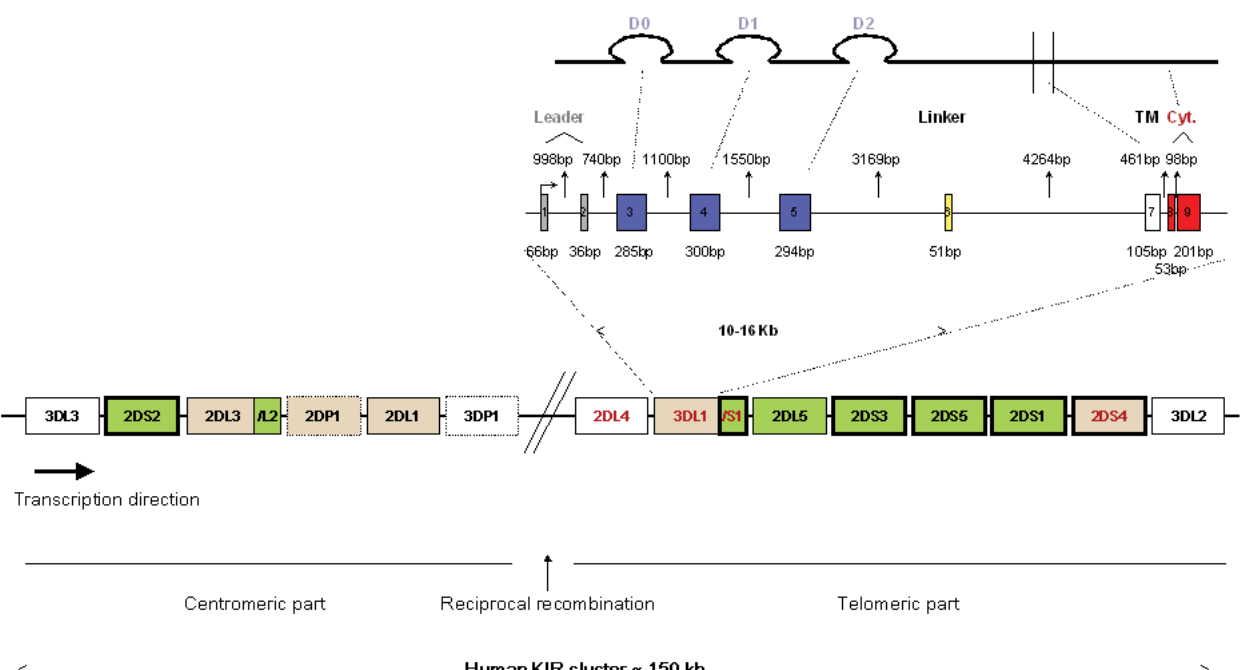
Figure 1. Organisation of the human KIR cluster. The Killer-cell Immunoglobulin-like receptor (KIR) genes are organised in a head-to-tail fashion on human chromosome region 19q13.4. Each gene has nine exons (illustrated for KIR3DL1 ) and is roughly 10–16 kb in length, with short and equally homologous intergenic sequences of about 2 kb separating each pair of genes. The organisation of the exon-intron structure of the different KIR genes is fairly consistent with the following basic arrangement: the signal sequence is encoded by the first two exons (in grey), each Ig domain (D0, D1, D2) corresponds to a single exon (exons 3–5, respectively, in blue), the linker (in yellow) and transmembrane (in white) regions are each encoded by a single exon (exons 6 and 7, respectively), and the cytoplasmic domain is encoded by two final exons (8 and 9, in red). Two systems have been generated for naming KIR genes. The first follows the CD nomenclature system as CD158a, CD158b, etc., based on an approximate centromerictelomeric order of the genes on chromosome 19 [58]. As the CD nomenclature is not used routinely since it does not reflect structure, function, expression or localization, the Human Genome Organization (HUGO) nomenclature will be used throughout this report (www.gene.ucl.ac.uk/nomenclature/genefamily/kir.html). The HUGO nomenclature system, accounts for KIR protein structure and consists of four major subdivisions based on two features: the number of extracellular Ig domains (2D or 3D) and the length of the cytoplasmic tail (L: long or S: short). This latter information determines their functions: inhibitory (L) or activating (S). The boxes in bold indicate the activating KIR genes, and the dotted boxes correspond to the pseudogenes. The two boundary genes of the KIR cluster, KIR3DL3 and KIR3DL2, and the centrally situated KIR3DP1 pseudogene and KIR2DL4 are present in almost all individuals and are therefore considered to be framework (or anchor) genes (shown in white) [59]. KIR3DL3 and KIR3DP1 delimit the centromeric part of the KIR locus, whereas KIR2DL4 and KIR3DL2 delimit the telomeric part. A 14 kb stretch of unique sequence separating KIR3DP1 from KIR2DL4 is the preferred site for reciprocal recombination, a mechanism resulting in the formation of new haplotypes by the reassortment of centromeric and telomeric genes. Apart from these framework genes, KIR gene content is highly variable in terms of both the number and type of genes present. Although initially considered to be separate genes, KIR2DL2 and KIR2DL3 segregate as alleles of the same locus. Similarly, KIR3DS1 segregates as an allele of the inhibitory KIR3DL1 . Overall, there are nine variable genes— KIR2DS2, KIR2DL2/2DL3, KIR2DL1, KIR3DS1/3DL1, KIR2DL5, KIR2DS3, KIR2DS5, KIR2DS1, KIR2DS4 —and one variable pseudogene ( KIR2DP1 ). KIR2DL5 KIR2DS3 and KIR2DS5 may be found in both parts of the locus. We decided to represent these genes in the telomeric part of the cluster in this figure. Two major KIR haplotype groups, A and B, are classically described. The A haplotype is defined as containing the KIR3DL3, KIR2DL3, KIR2DL1, KIR2DL4, KIR3DL1, KIR2DS4 and KIR3DL2 genes. KIR gene polymorphism adds further diversity to the KIR region, with multiple alleles known for each KIR locus. Allele identification was performed for KIR2DL4, KIR2DS4 and KIR3DS1/3DL1 (indicated in red). This makes it possible to subdivide haplotype A further, according to the presence of the two common forms of KIR2DS4 —the wild type KIR2DS4wt (haplotype A1) or the deletion variant KIR2DS4del, identical to KIR2DS4wt except for a 22 base-pair deletion causing a frame shift in translation (haplotype A2). B haplotypes are more variable and are characterised by the presence of more than one activating KIR gene. Genes that can be present in both group A and group B KIR haplotypes are shown in brown, and genes and/or alleles specific to group B KIR haplotypes are shown in